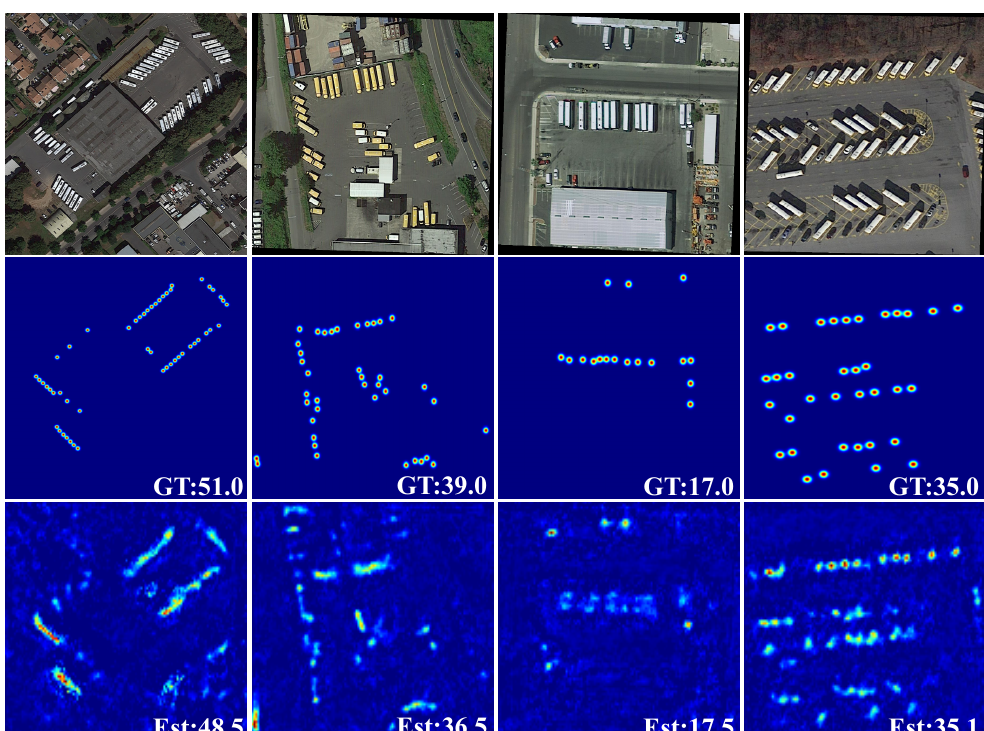
Figure 6. Subjective results on the RSOC_large-vehicle